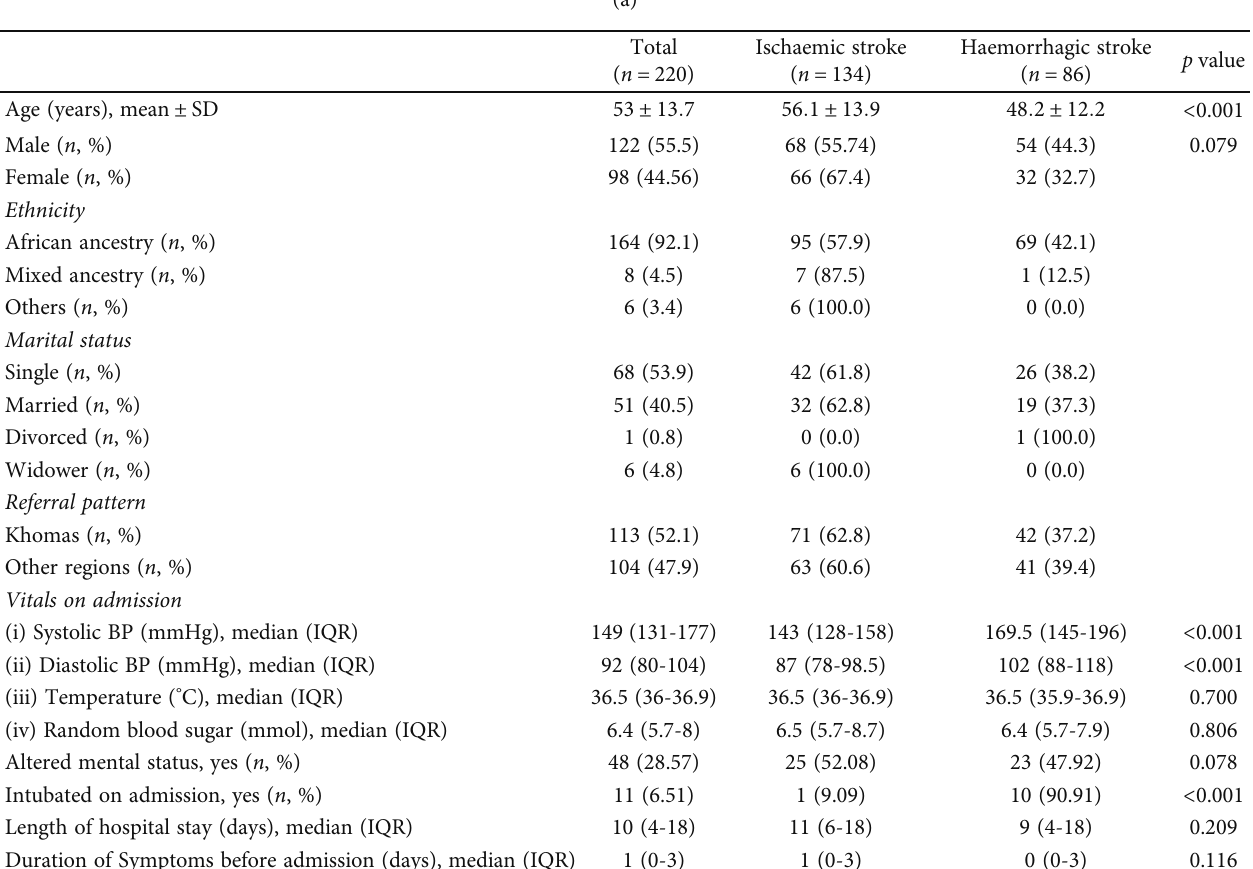
Table 1: Demographics, characteristics, risk factors, and management of stroke